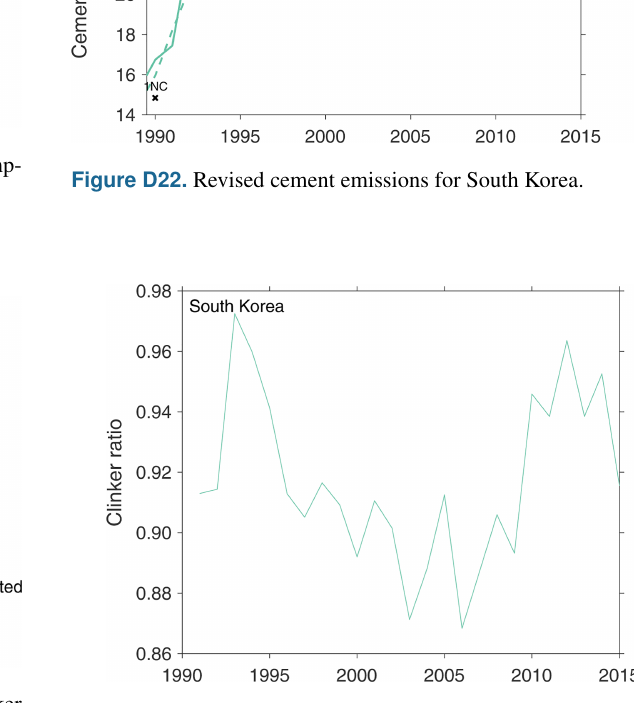
Figure D23. South Korea’s approximate clinker ratio with no ac- count for clinker trade.